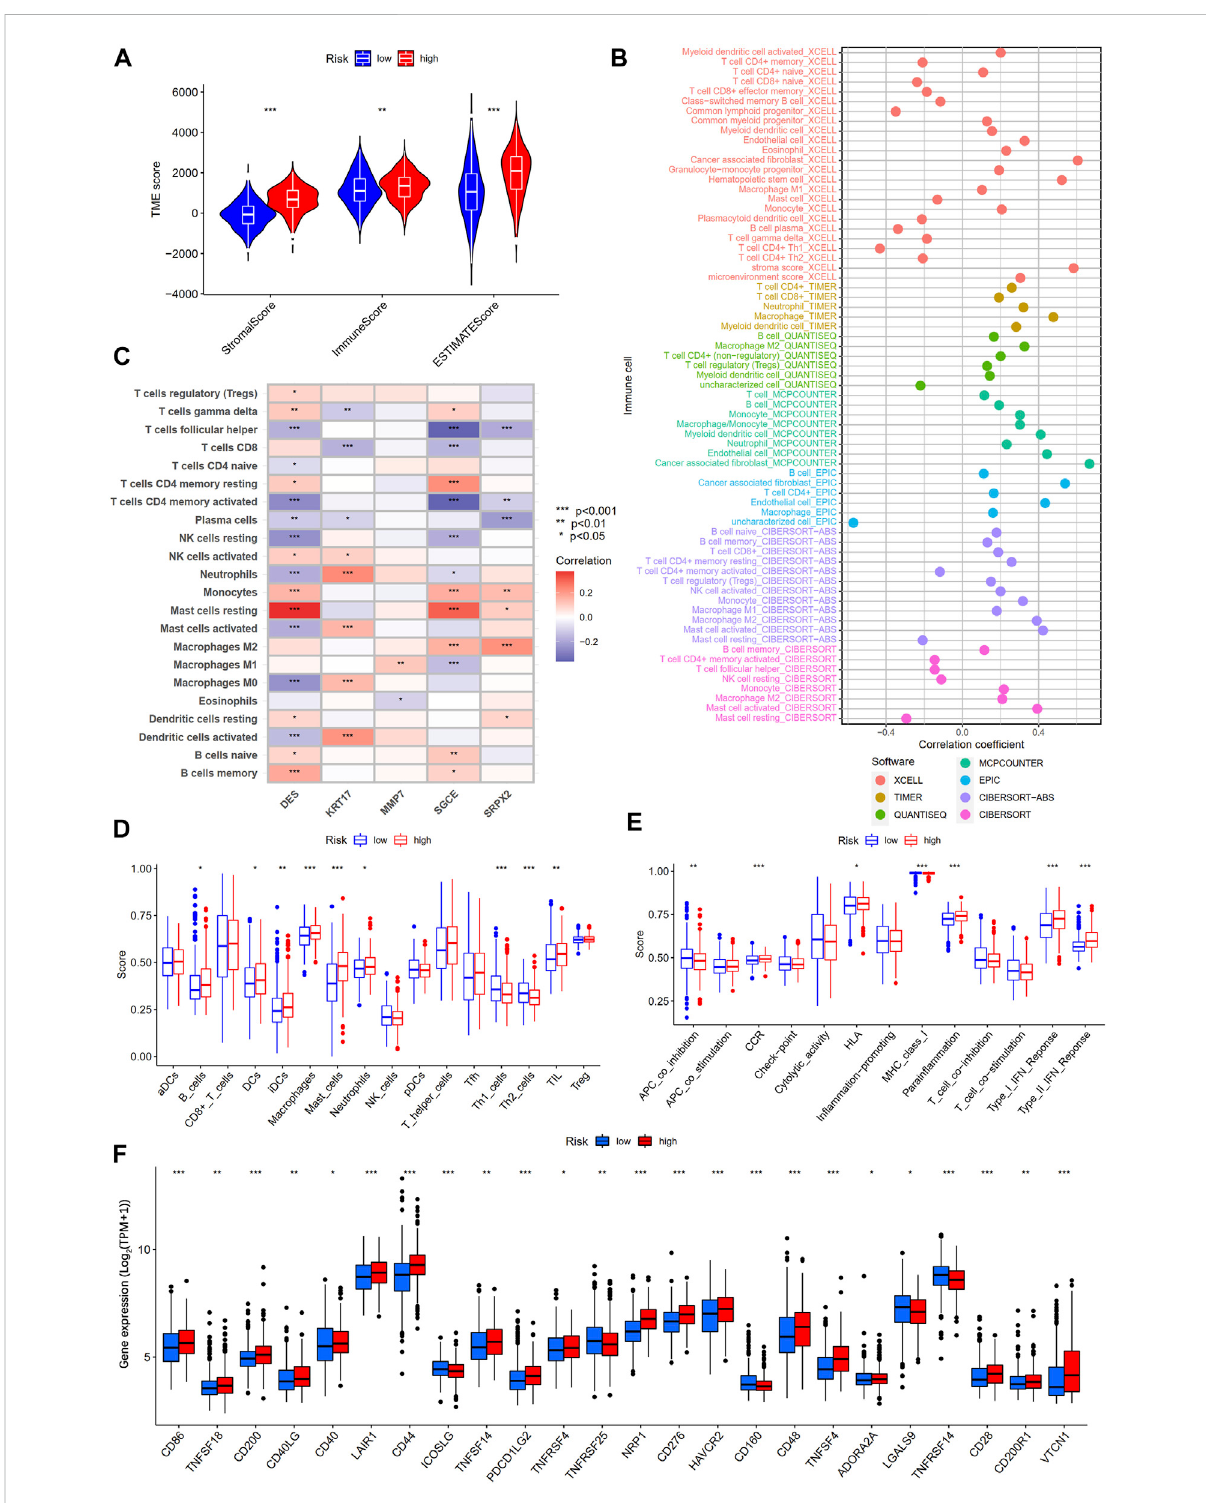
FIGURE 10 Differential analysis of tumor immune microenvironment between high- and low-risk groups. (A) TME score between high- and low-risk groups. (B) Spearman correlation analysis of immune components and risk scores based on XCELL, TIMER, QUANTISEQ, MCPCOUNTER, EPIC, CIBERSORT-ABS, and CIBERSORT algorithms. (C) Spearman correlations between the abundance of immune cells and fi ve genes in the prognostic model. (D) 16 immune cells and (E) 13 immune-related functions between the high- and low-risk groups by ssGSEA. (F) The expression of immune checkpoint-related genes between the high- and low-risk